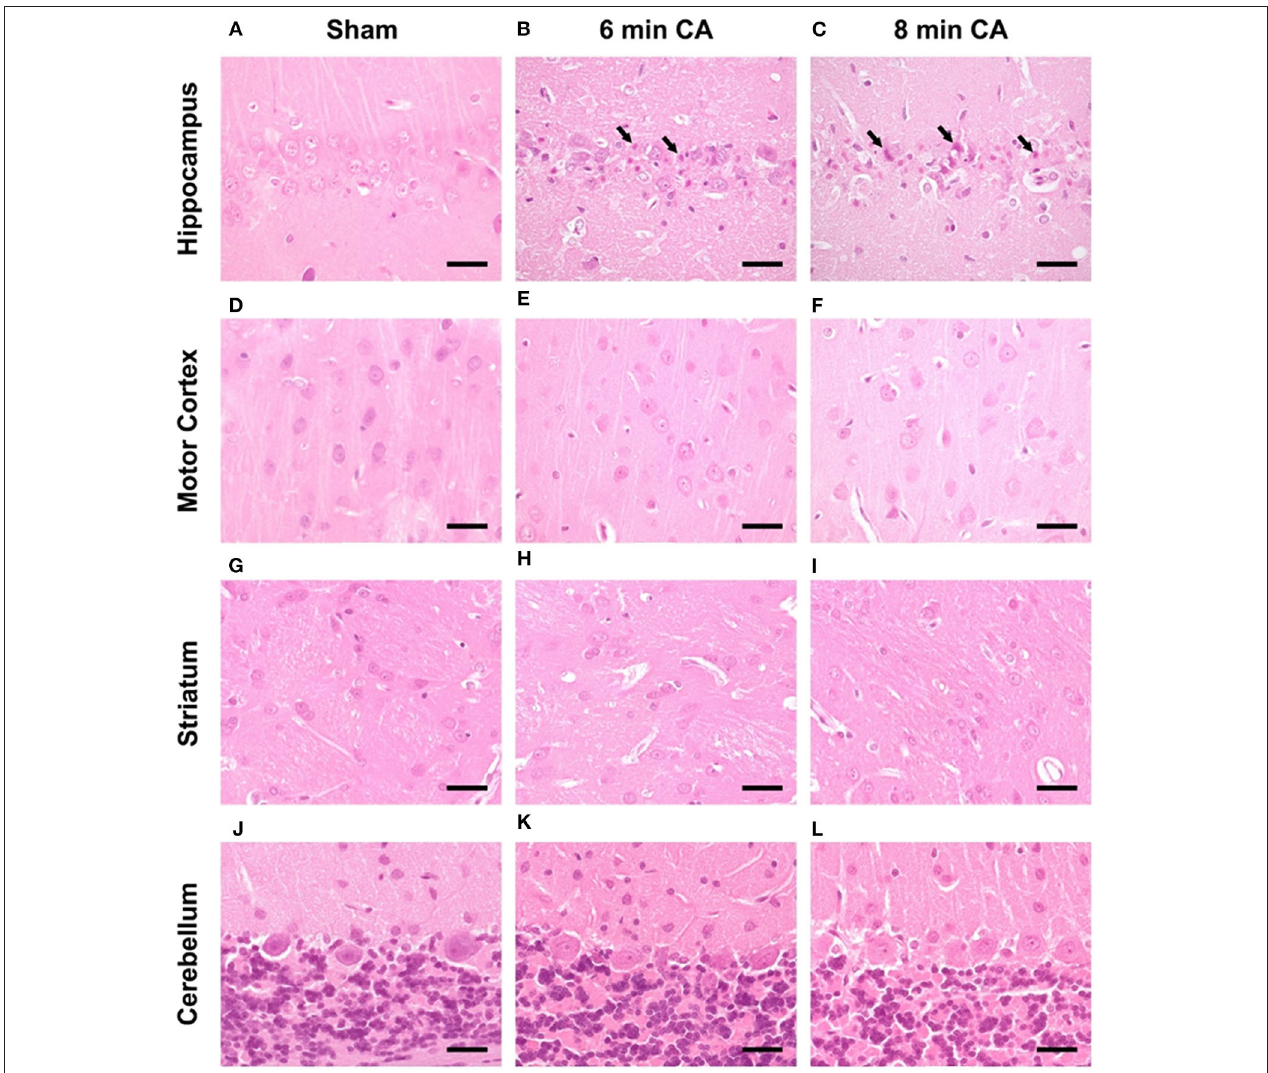
FIGURE 7 | Representative pictures of hippocampus, motor cortex, striatum and cerebellum at 14 days after CA, HE-staining, bar = 30 µ m. (A–C) Hippocampus, (A) sham animal with viable pyramidal neurons, no lesions present. (B) 6min CA animal with many necrotic neurons (arrows) and few viable pyramidal neurons; (C) 8min CA animal with many necrotic neurons (arrows) and only scattered viable pyramidal neurons. (D–F) Motor cortex, viable neurons in sham (D) as well as 6 (E) and 8min CA (F) animals, no lesions present. (G–I) Striatum, viable neurons in sham (G) as well as 6 (H) and 8min CA (I) animals, no lesions present. (J–L) Cerebellum, viable neurons in sham (J) as well as 6 (K) and 8min CA (L) animals, no lesions present. CA, cardiac